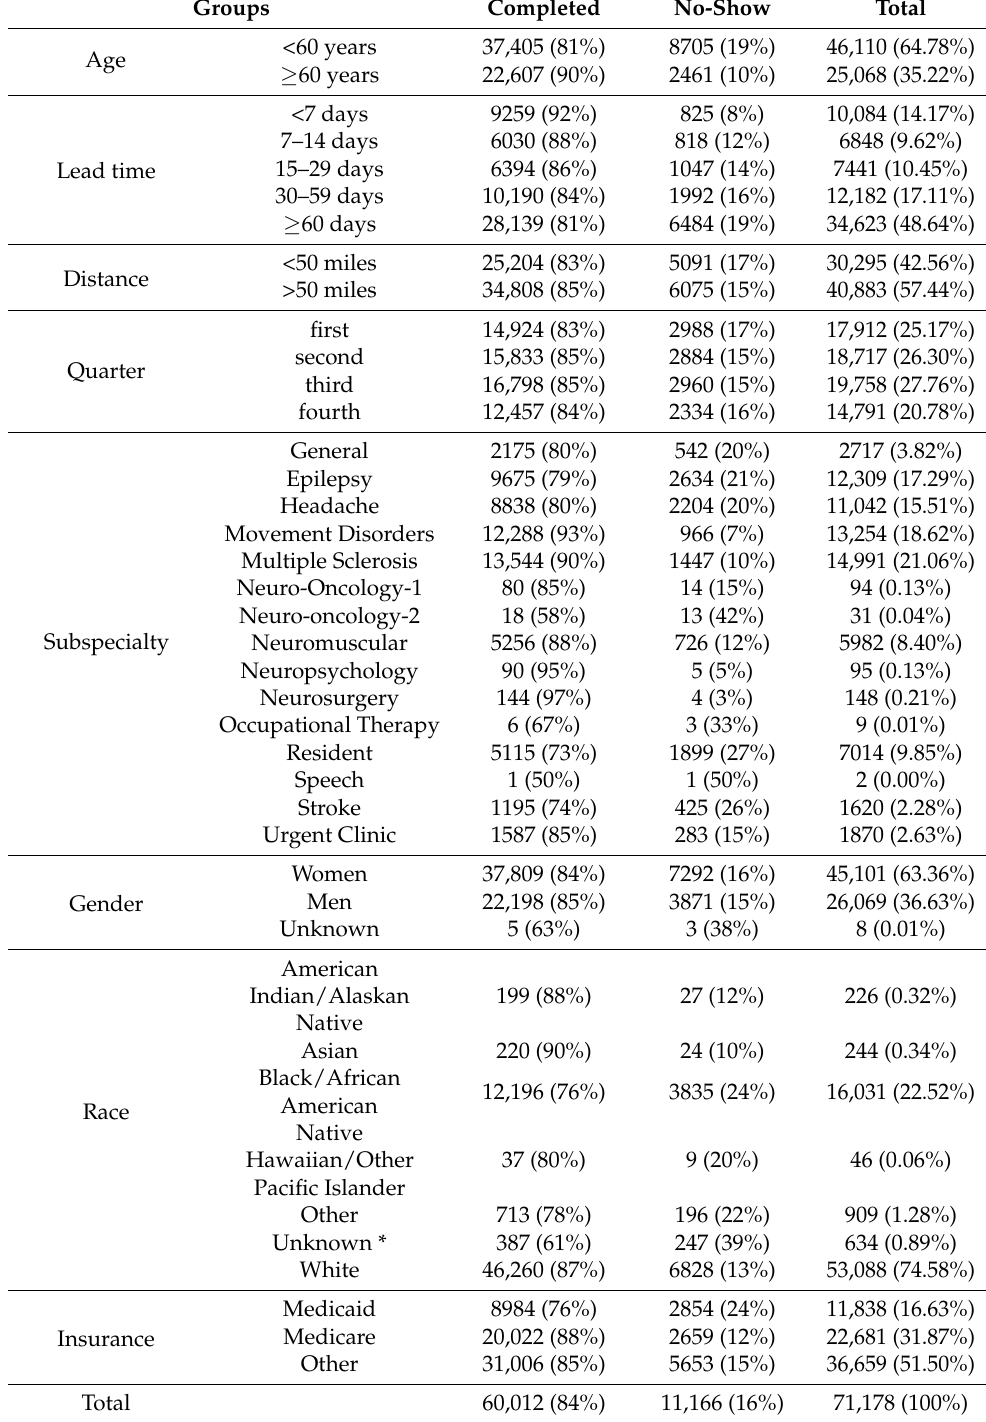
Table 1. Study population characteristics (N =